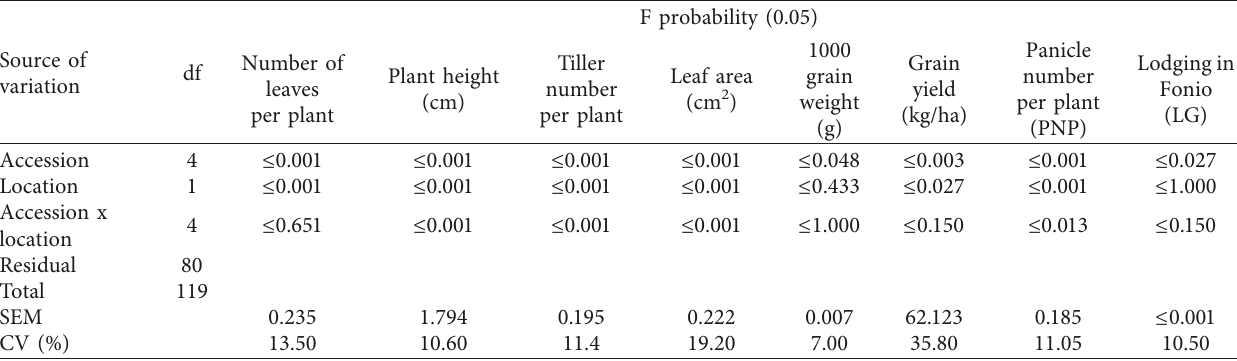
Table 3: Analysis of variance for yield and yield components as influenced by accession, location, and accession x location interaction during the 2019 cropping season.